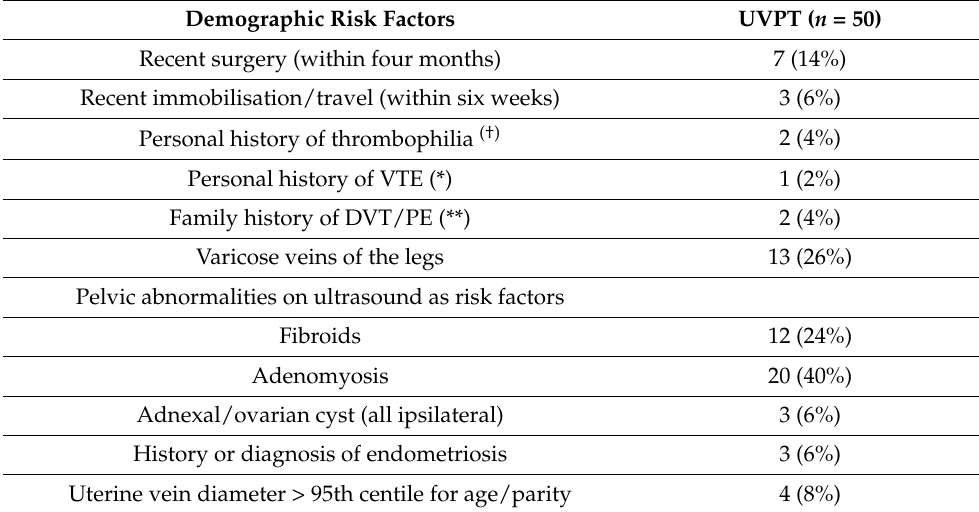
Table 1. Cont. Demographic Risk Factors UVPT ( n = 50) Recent surgery (within four months) 7 (14%) Recent immobilisation/travel (within six weeks) 3 (6%) Personal history of thrombophilia (†) 2 (4%) Personal history of VTE (*) 1 (2%) Family history of DVT/PE (**) 2 (4%) Varicose veins of the legs 13 (26%) Pelvic abnormalities on ultrasound as risk factors Fibroids 12 (24%) Adenomyosis 20 (40%) Adnexal/ovarian cyst (all ipsilateral) 3 (6%) History or diagnosis of endometriosis 3 (6%) Uterine vein diameter > 95th centile for age/parity 4